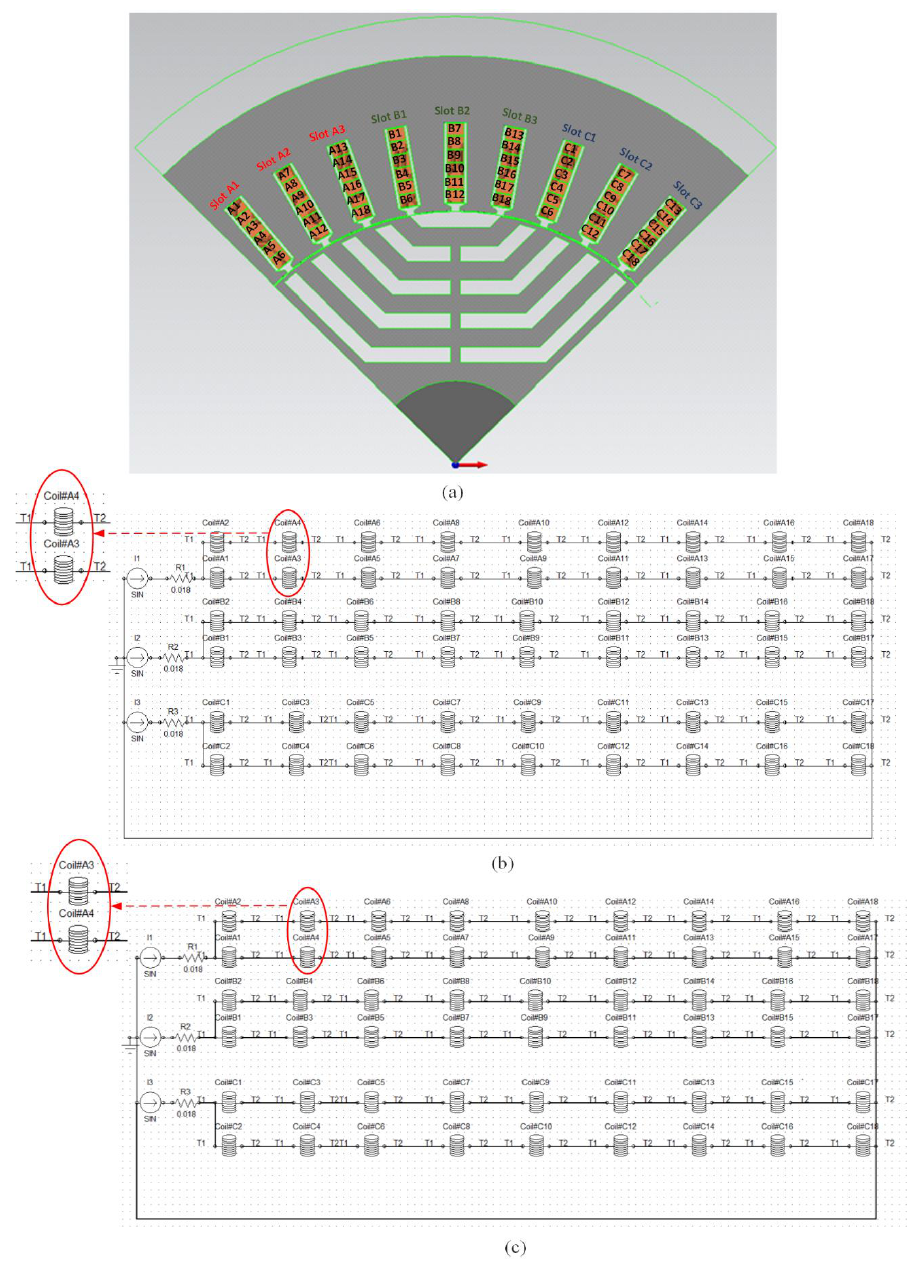
Figure 4. ( a ) Geometry model of a quarter of SynRM in Magnet software, ( b ) correct transposition circuit, and ( c ) incorrect transposition conductors.